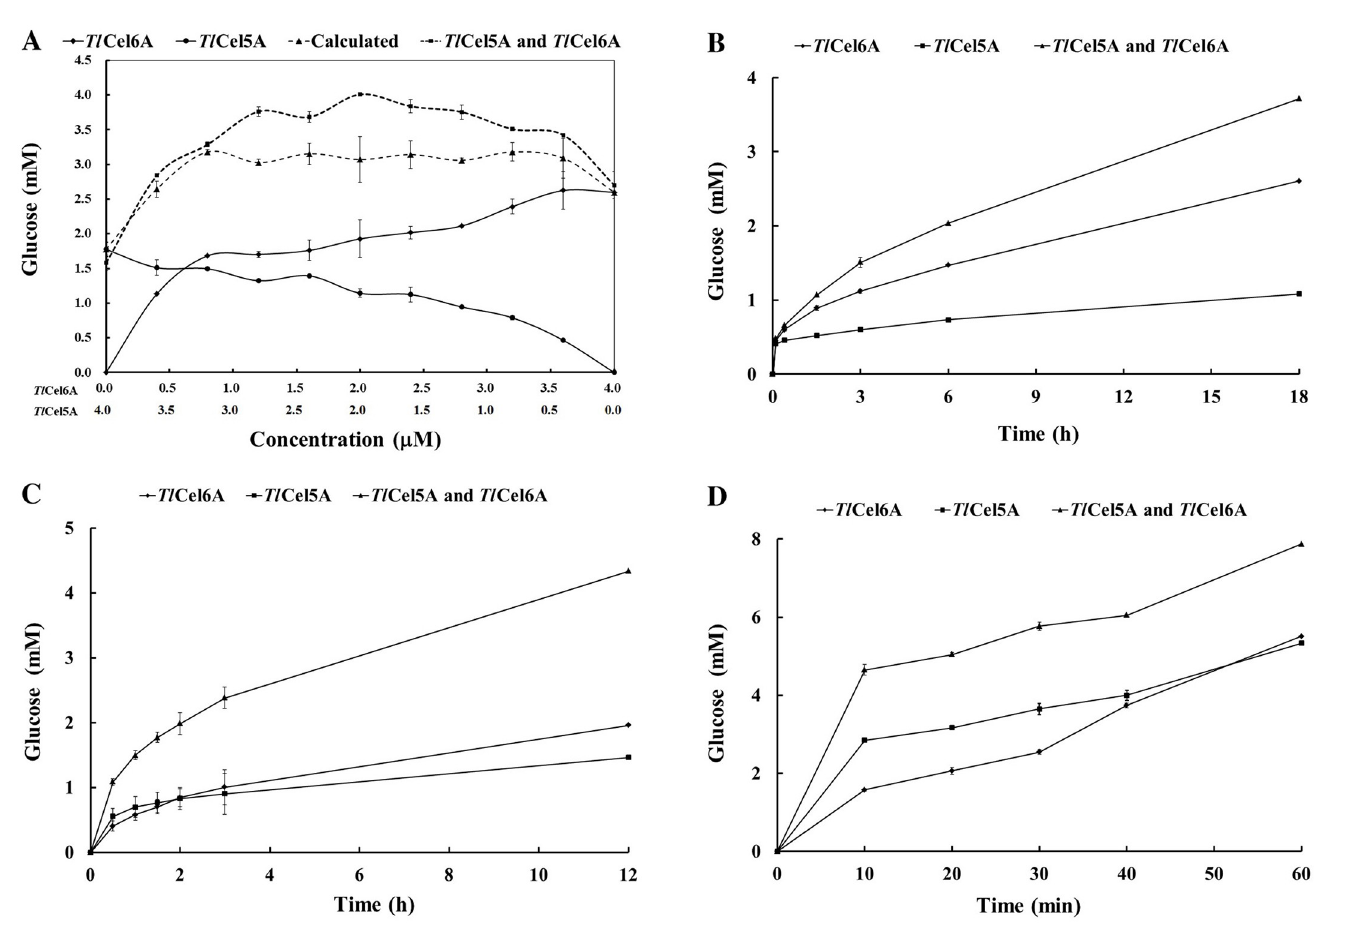
Fig 3. Synergistic actions of Tl Cel5A, Tl Cel6A and a commercial glucosidase on the hydrolysis of different cellulose substrates. (A)Avicel (5.0 mg/mL) hydrolysis by the Tl Cel5A, Tl Cel6A, and their combination at different ratios. (B)Avicel (2.5 mg/mL) hydrolysis by the Tl Cel5A, Tl Cel6A, and their combination at the ratio of 1:1. (C) SECS (5.0 mg/mL) hydrolysis by the Tl Cel5A, Tl Cel6A, and their combination at the ratio of 1:1. (D) PASC (2.5 mg/mL) hydrolysis by the Tl Cel5A, Tl Cel6A, and their combination at the ratio of 1:1. Each experiment had triplicate, and the data were shown as mean ± standard deviation (n = 3).